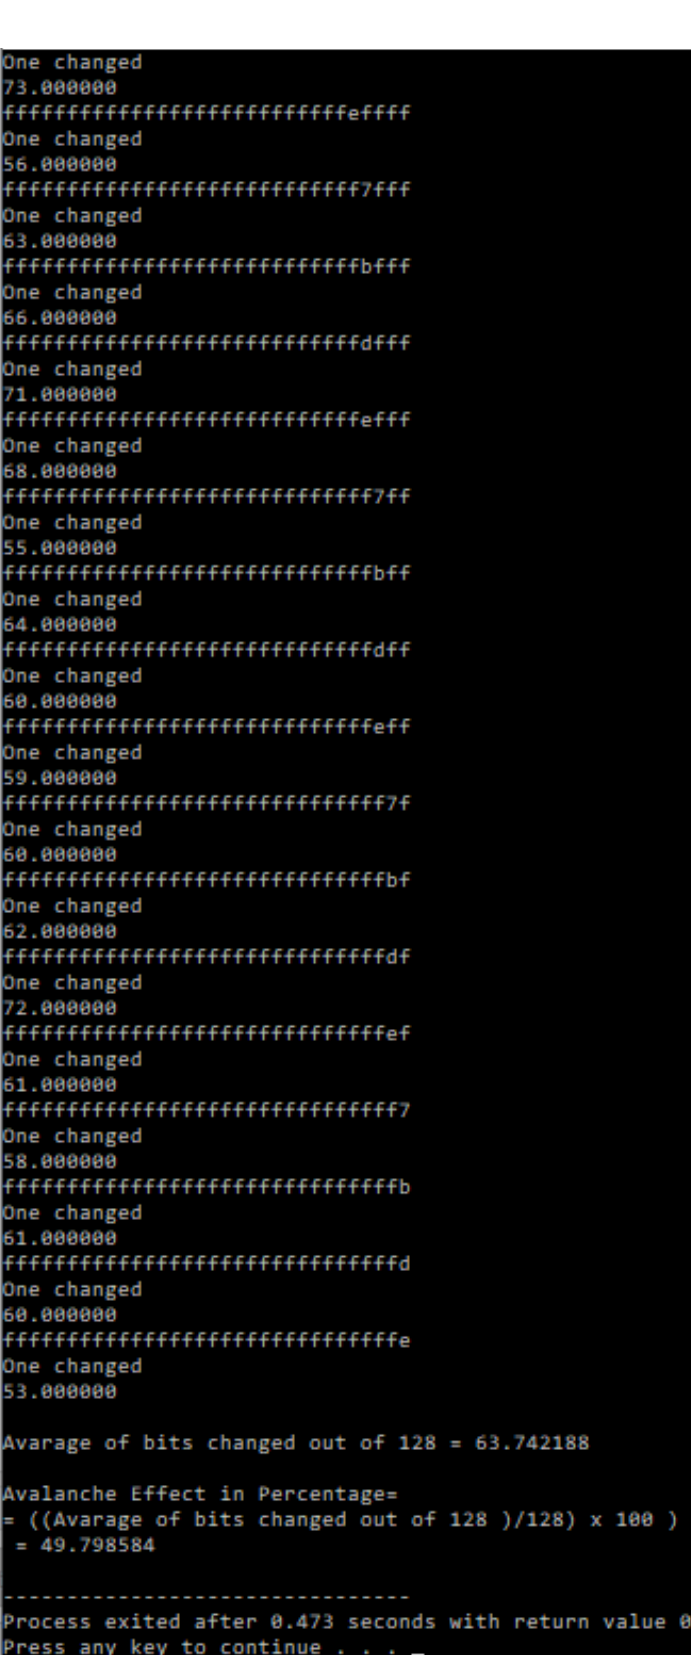
Figure 12. Experimental Avalanche Effect of Mag_Serpent when one bit of a plaintext was